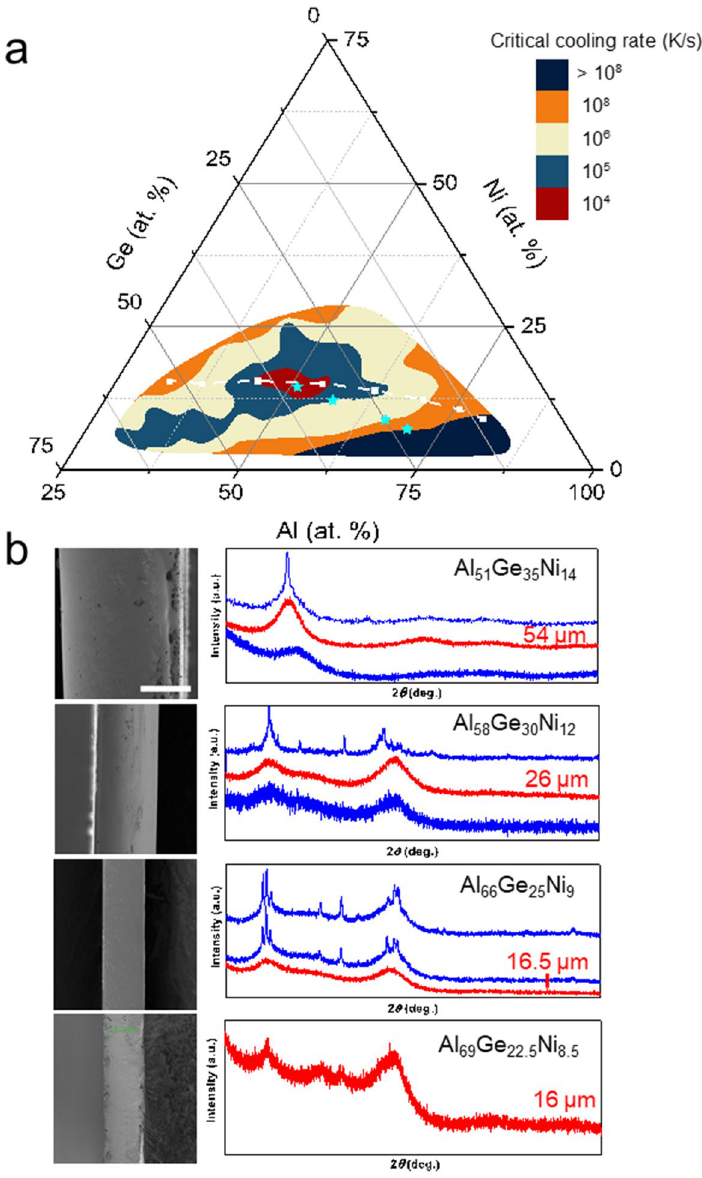
Figure 3. Critical cooling rate mapping and results from melt spinning samples. ( a ) Summary of critical cooling rates of the considered Al–Ni–Ge alloys spanning 6 orders of magnitude. The white dash line labels the compositions shown in Fig. 2. ( b ) Measured R c was further revealed with melt spinning samples. For 4 different compositions marked as stars in ( a ), melt spinning samples with decreasing rotation speeds were made and glass to crystalline transition was revealed by XRD. With decreasing rotation speed giving thicker sample thickness, critical thickness of each composition is revealed. XRD curves from these thicker to thinner samples are shown from top to bottom of each composition. Critical thickness was measured by SEM from amorphous sample of the largest thickness, with corresponding XRD curves shown in red. XRD curves of samples either above or below critical thickness are shown in blue. Scale bar: 20